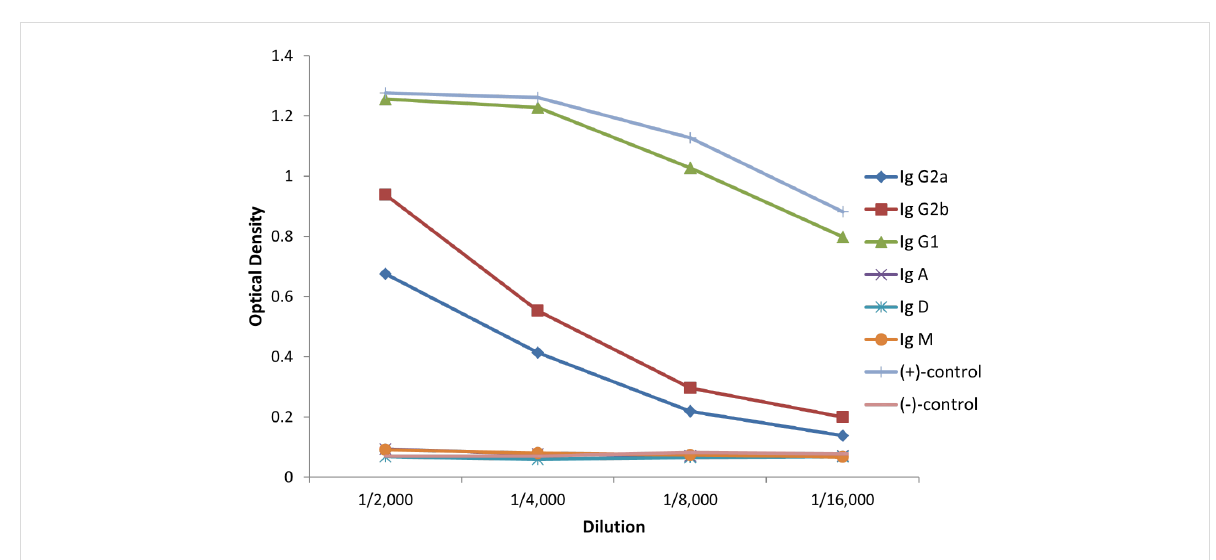
Figure 3: Determination of the isotypes of the antibodies induced by 4’F-TF-Thr 6 -MUC1(20)-TTox vaccine 18b (antiserum of mice 2; for more details cf. Supporting Information File 1).